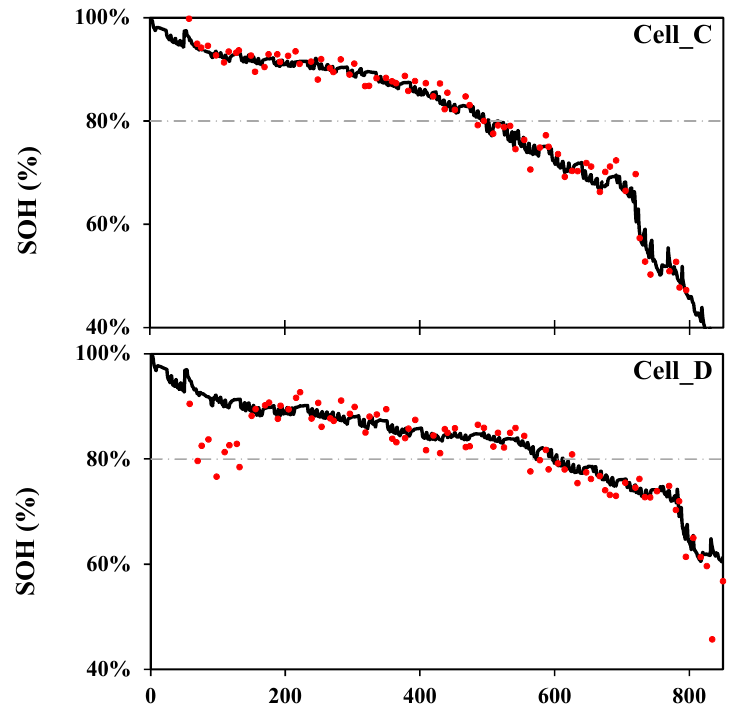
Figure 9. Estimations and actual data of SOH from random samplings of cells A – D using cell A for model construction. Table 7. Online SOC and SOH estimation errors of the four cells in the random sampling test.